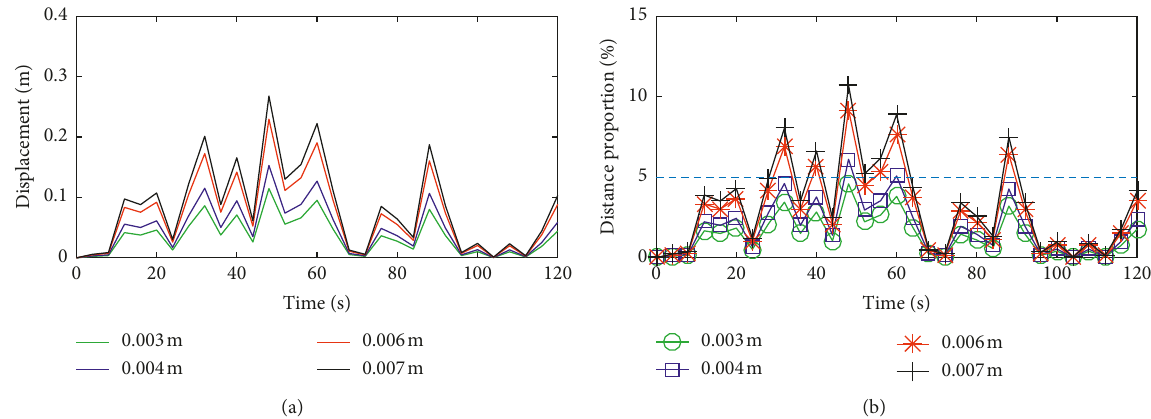
Figure 12: Lateral vibration of the vertical rope under different axial wobble amplitudes of the head sheave. (a) Total lateral vibration displacements. (b) Distance